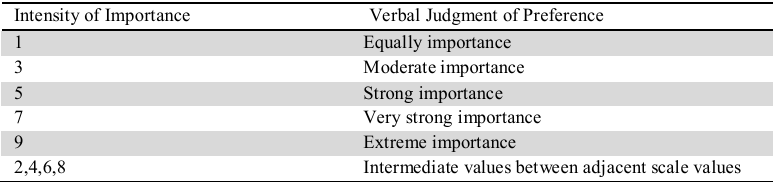
Fig. 1. Scale of comparisons of the